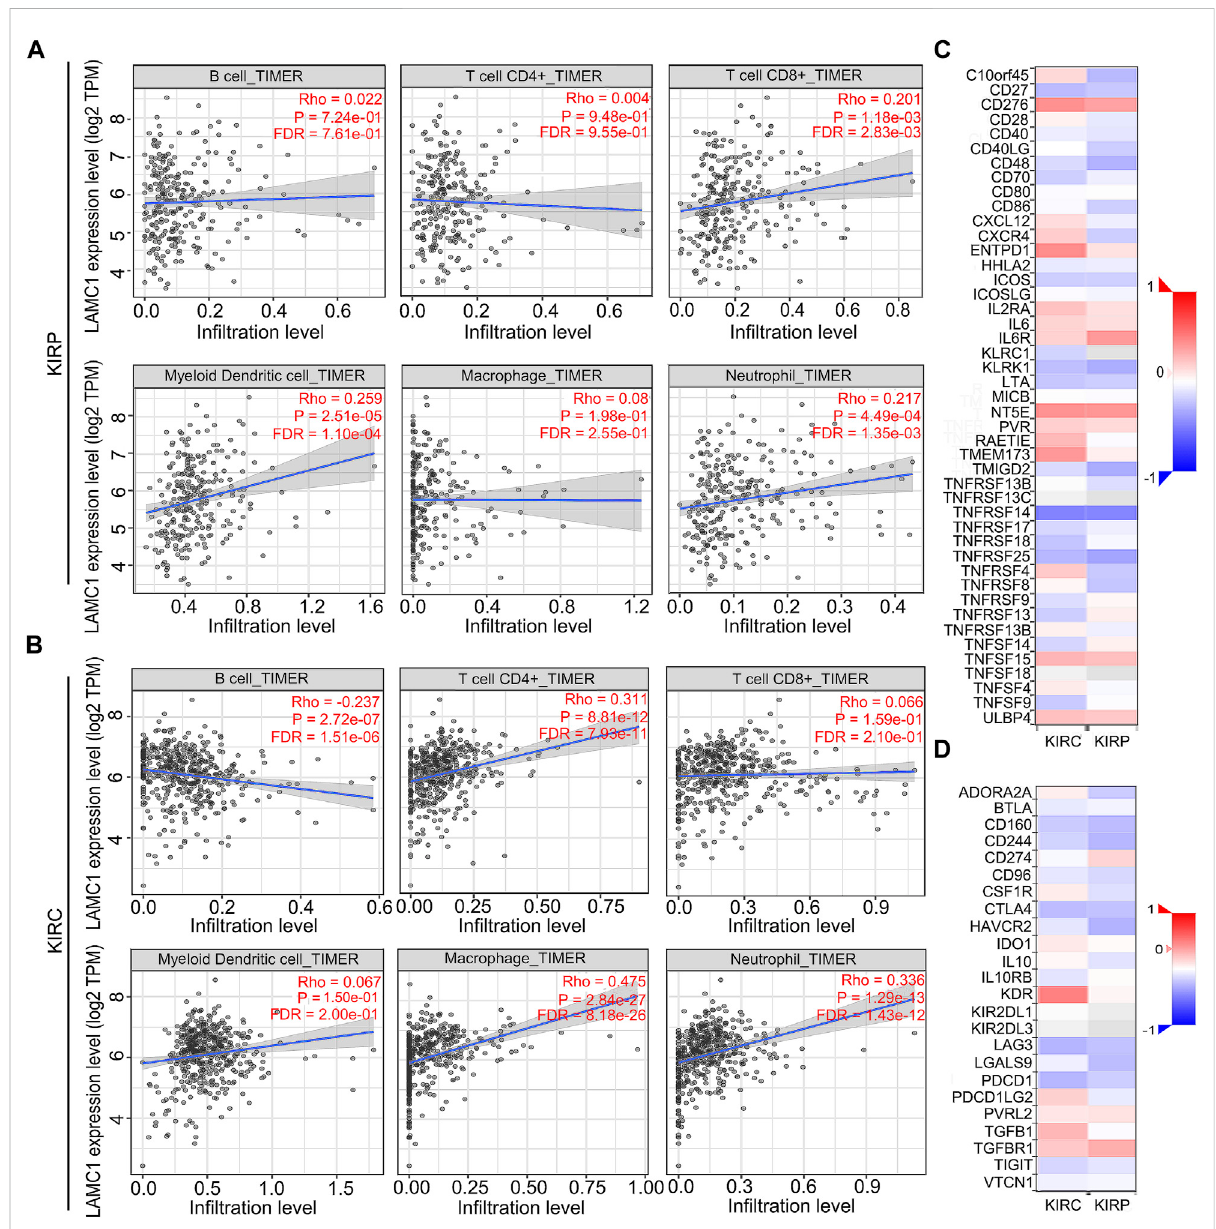
FIGURE 5 Correlationanalysisof LAMC1 expressionandimmunecellin fi ltrationlevelsandimmunoregulatorsinKIRPandKIRC. (A,B) Correlationbetween LAMC1 expression and tumor immune cells in KIRP and KIRC samples identi fi ed using the TIMER algorithm. (C) Relationships between expression of LAMC1 and 45 types of immunostimulators in human KIRP and KIRC using TISIDB database. Red color indicates positively related and blue color indicates the negatively related immunostimulators. (D) Relationships between expression of LAMC1 and 24 types of immunoinhibitors in human KIRP and KIRC samples identi fi ed using TISIDB database. Red colorindicates positively related and bluecolor indicates thenegativelyrelated